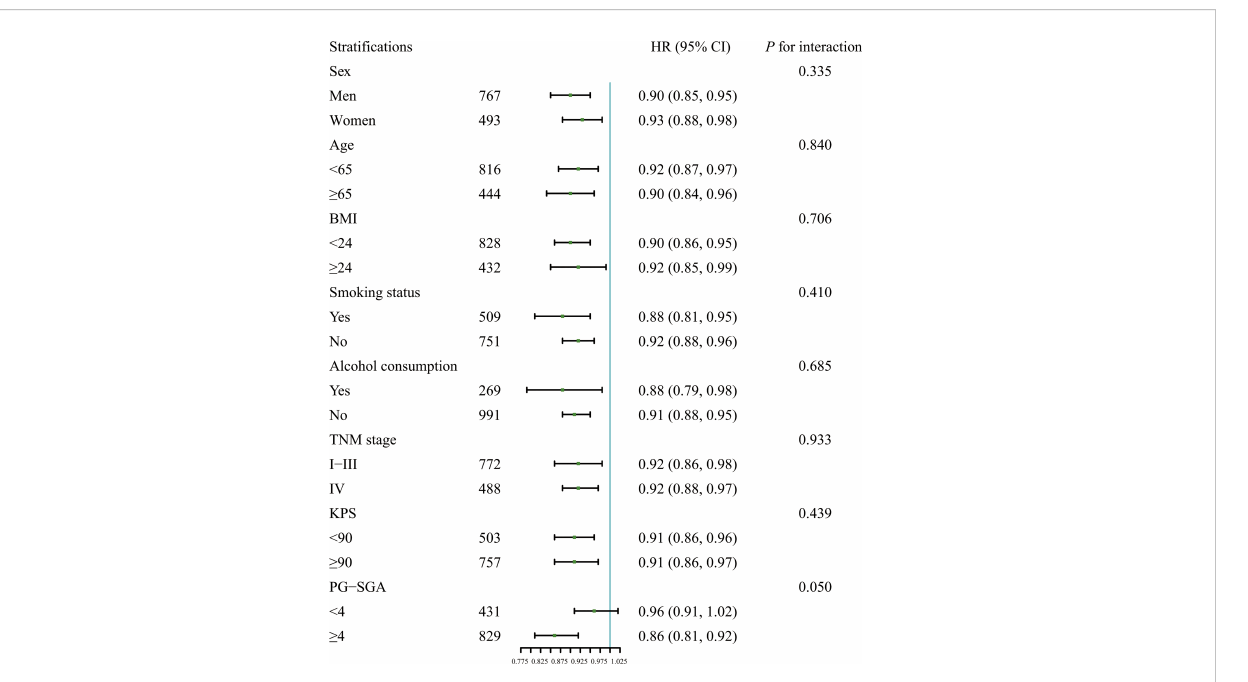
FIGURE 2 Association between the CALLY index and OS in patients with CRC in different strati fi cations including sex (men vs. women), age (less than 65 years vs. 65 years or more), BMI (less than 24 kg/m 2 vs. 24 kg/m 2 or more), smoking status (Yes vs. No), alcohol consumption (Yes vs. No), PG-SGA (less than 4 vs. 4 or more), tumor stage (I/II/III vs. IV), and KPS (less than 90 vs. 90 or more). Models were adjusted for sex, age, BMI, smoking status, alcohol consumption, TNM stage, KPS and PG-SGA, but not adjusted for the strati fi cation variable. HR, Hazard ratio; CI, con fi dence interval; BMI, body mass index; KPS, Karnofsky performance status score; PG-SGA, Scored Patient-Generated Subjective Global Assessment; CALLY, C-reactive protein-albumin-lymphocyte; OS, overall survival; CRC, colorectal